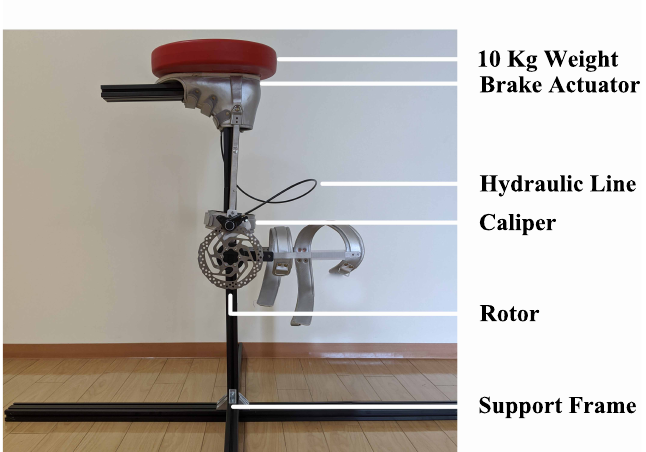
Figure 4. Experimental setup for measuring the maximum and dynamic braking torque. The exoskeleton is inverted in this